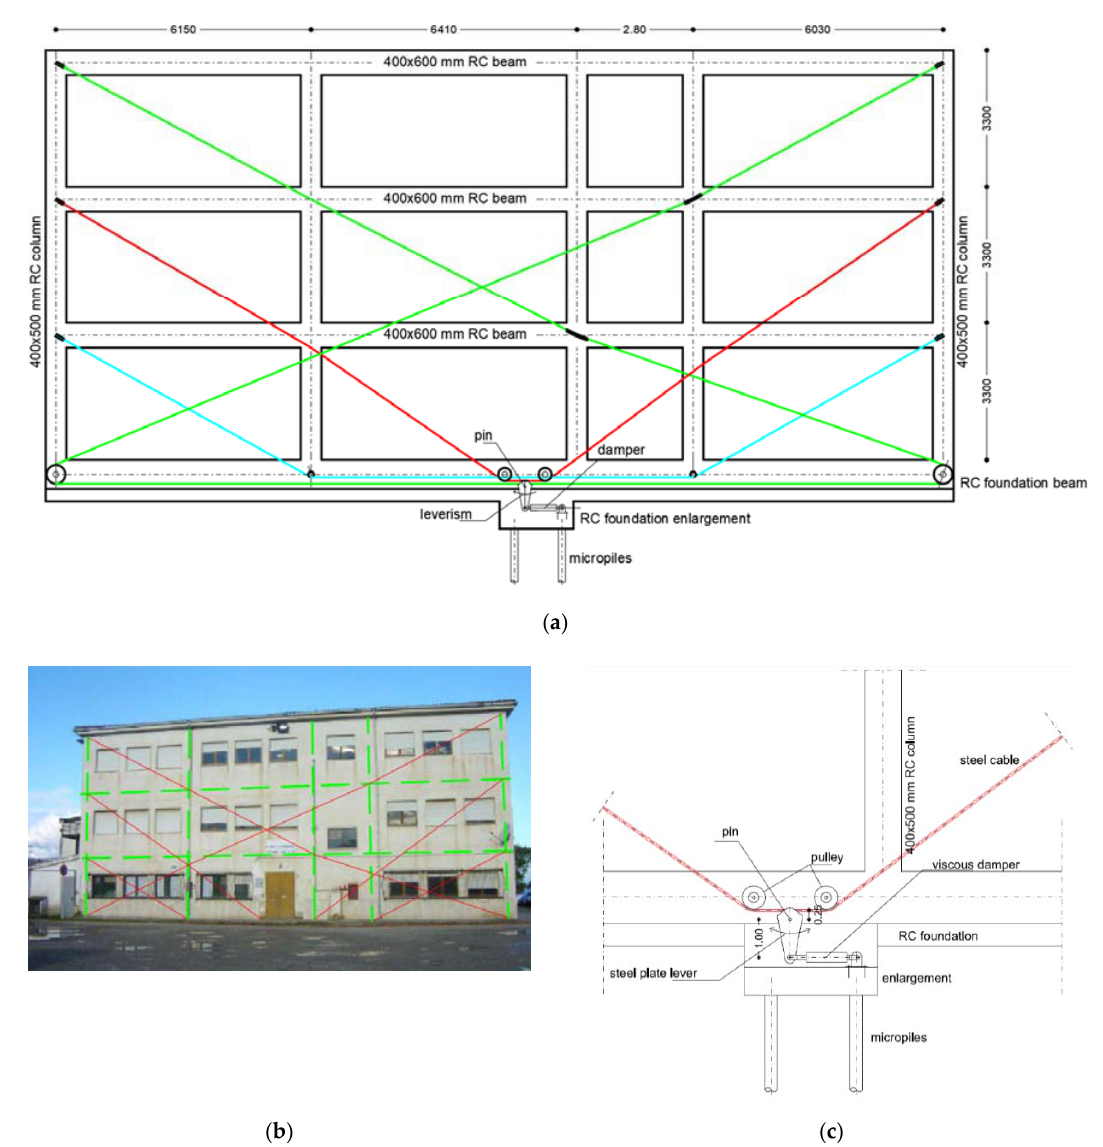
Figure 12. ( a ) System layout on the main RC frame of the benchmark building: in green, red and cyan are represented, respectively, steel cables linking the 3th, 2th, and 1th floor to the foundation of the building; ( b ) Cable system layout depicted on the building prospect: steel cables (red lines), RC frame (dashed green lines); ( c ) transferring system of cable displacement to the viscous damper.